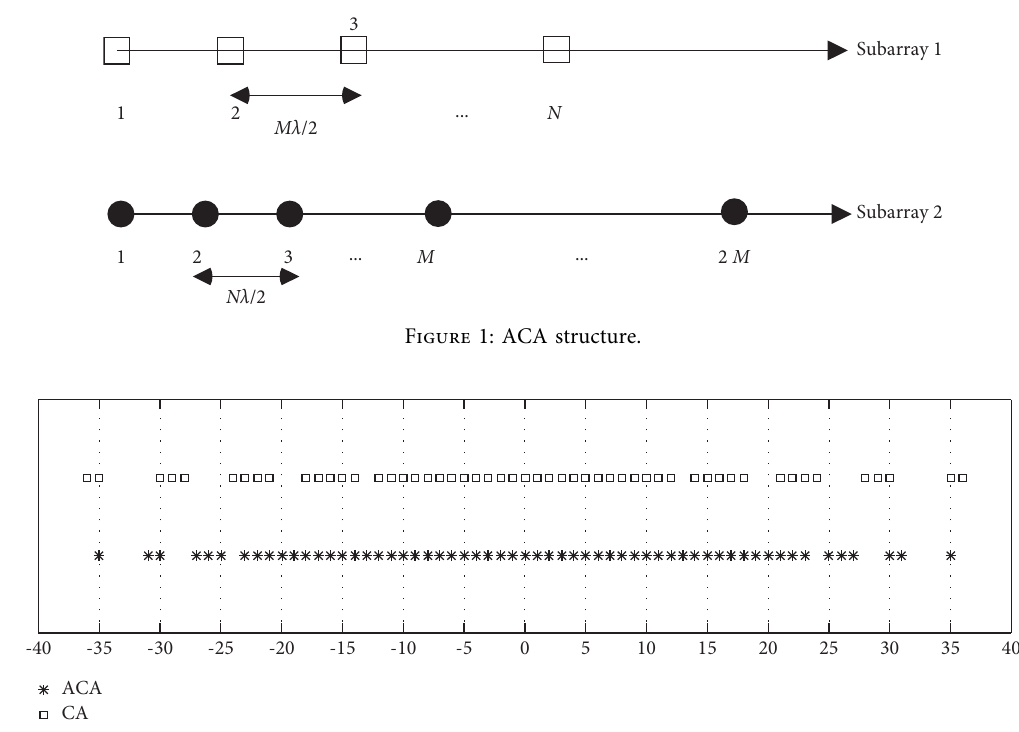
Figure 2: The virtual array structure after fourth-order cumulant extension for ACA and